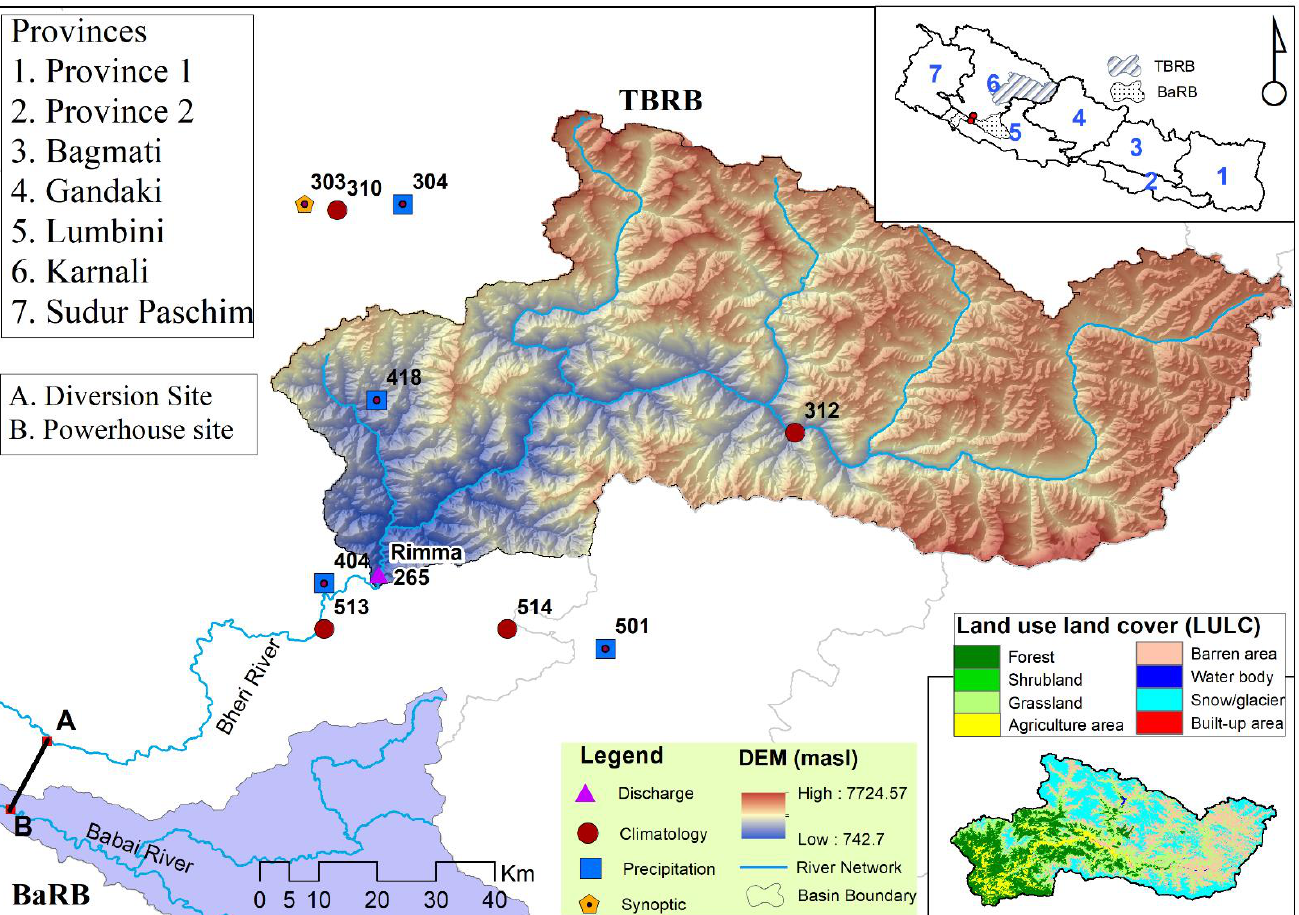
Figure 1. Location of the hydro-meteorological stations, land use land cover (LULC), digital elevation model (DEM), and hill shade of the study area at the Thuli Bheri River Basin (TBRB) and the provinces in the country and Karnali Province enclosing the study area (inset). The lower left of the figure shows the Babai River Basin (BaRB) and the diversion tunnel connecting (A) diversion site in Bheri river and (B) powerhouse site in Babai river of Bheri Babai Diversion Multipurpose Project (BBDMP).